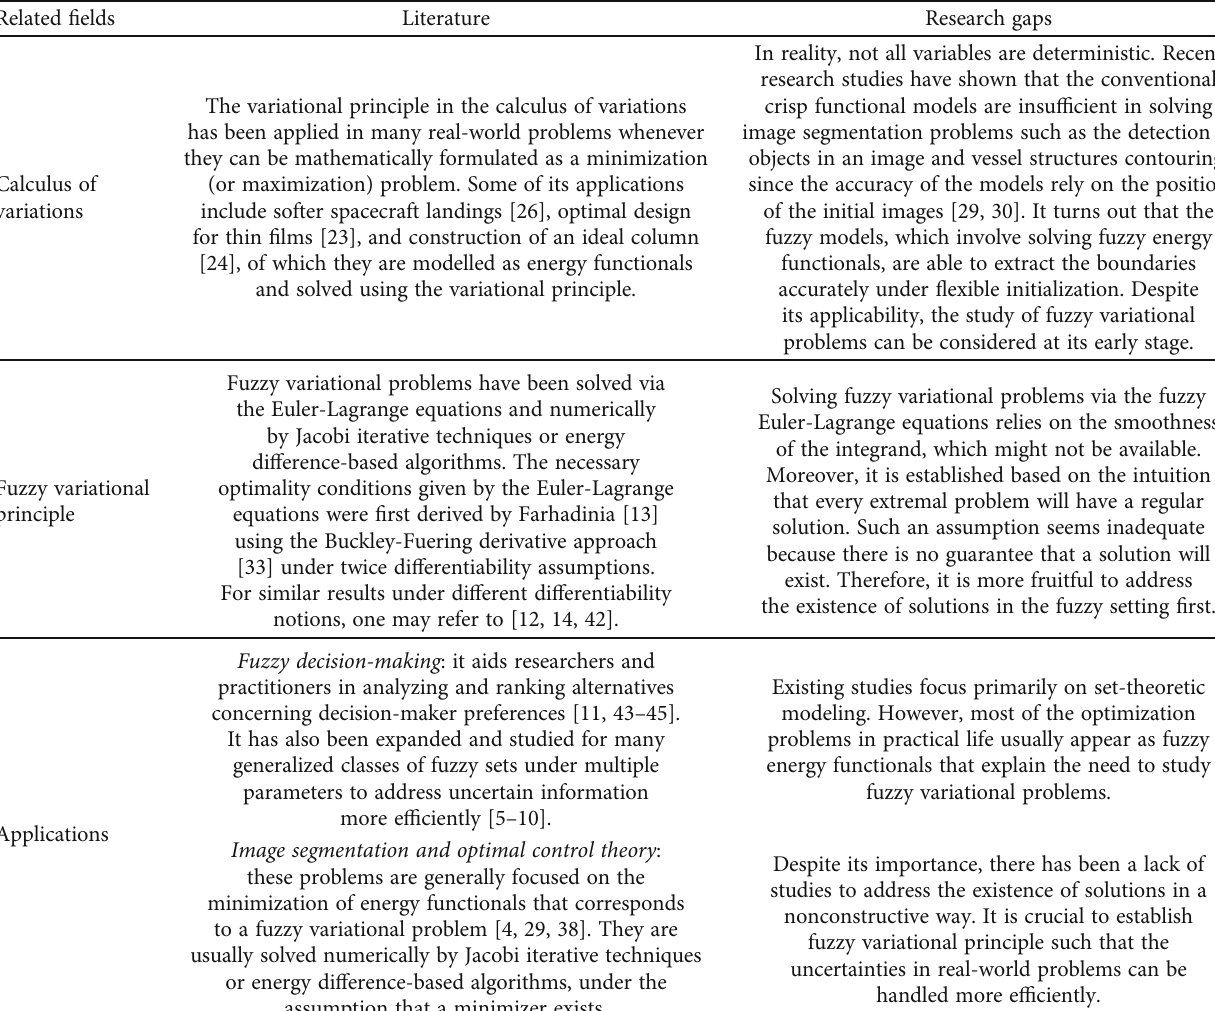
Table 1: Review of the related fi elds and their research